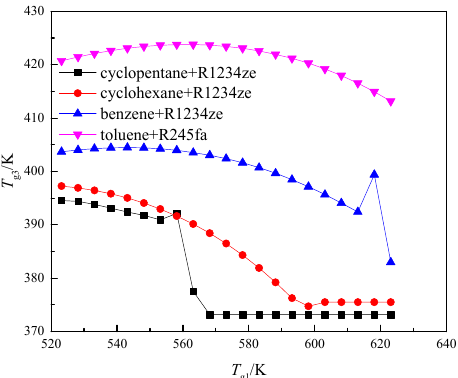
Figure 11. Effects of T g1 on the exhaust gas temperature at the exit of the HTL evaporator.